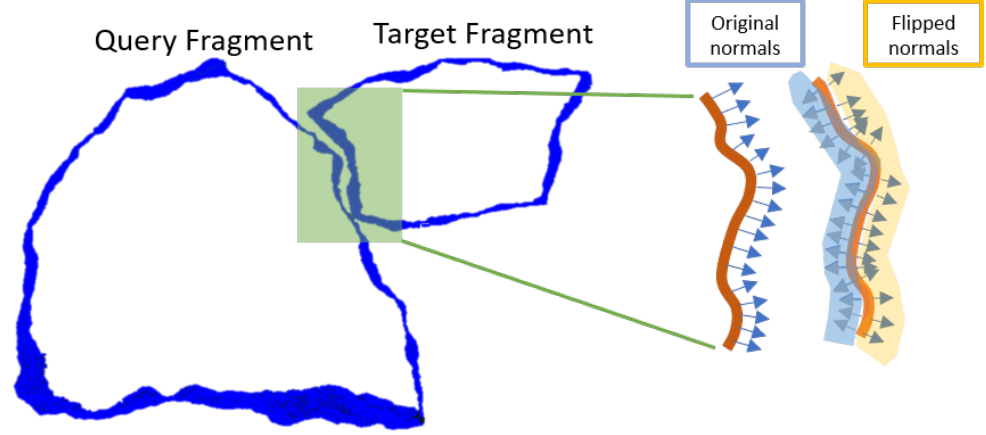
Figure 7. The normal coherence constraint. The target contour’s normal surfaces are flipped to meet the normal-coherence criterion and obtain similar